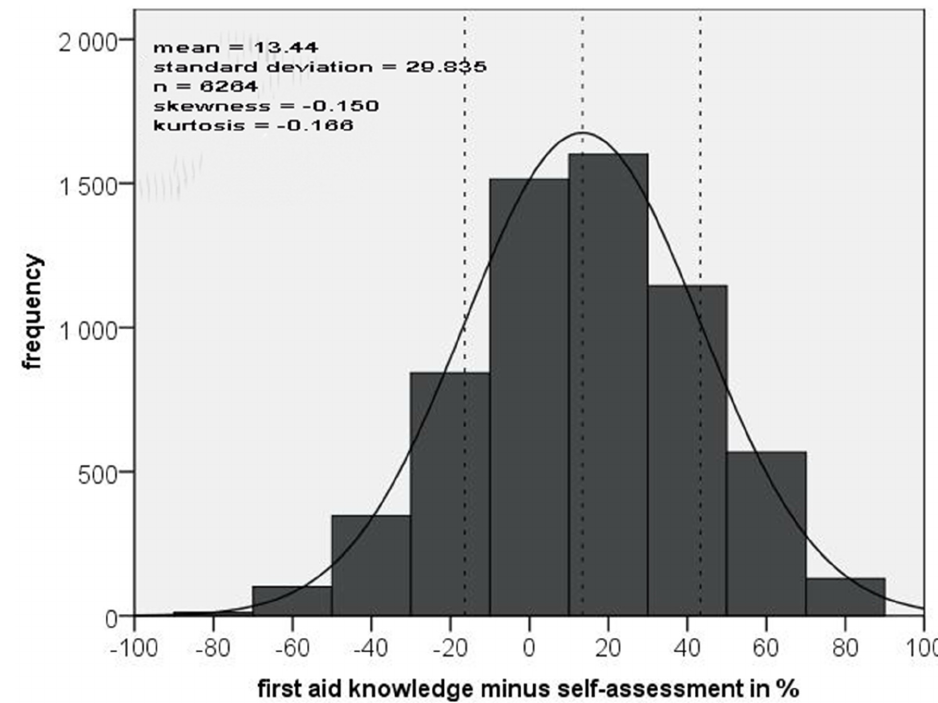
Figure 3. Number of correctly answered first aid questions vs. self-assessment.